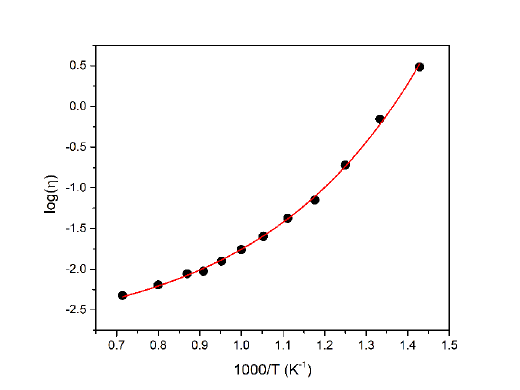
Zr Ti alloy. Fitting 60.0 32.5 7.5